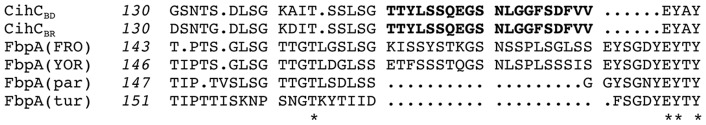
Alignment of partial sequences of FbpA and CihC.Alignment of FbpA amino acid sequences from two different B. hermsii (FRO and YOR), B. turicatae (tur) and B. parkeri (par) isolates with the putative central region of CihCBR (B. recurrentis) and CihCBD (B. duttonii) that bind human complement regulators, C4bp and C1-Inh (in bold). Identical residues are marked with asterisks.